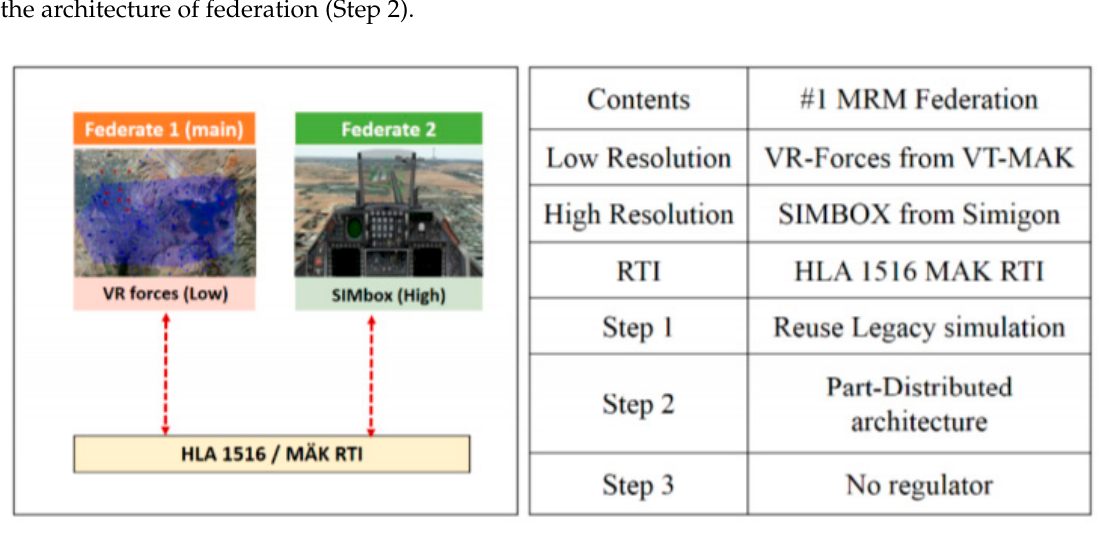
Figure 13. MRM federation configuration.